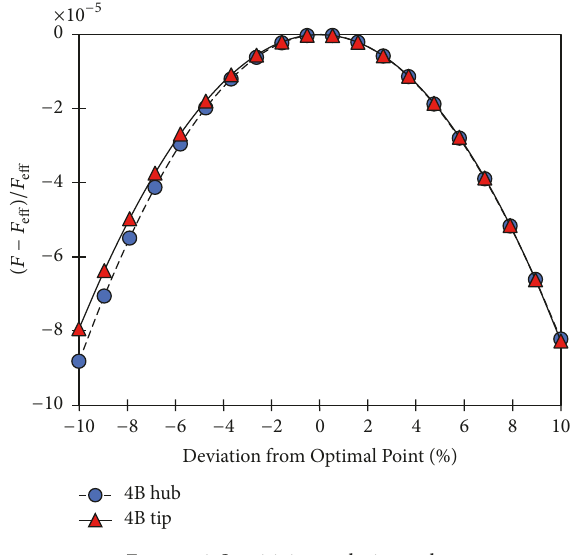
Figure 6: Sensitivity analysis results.